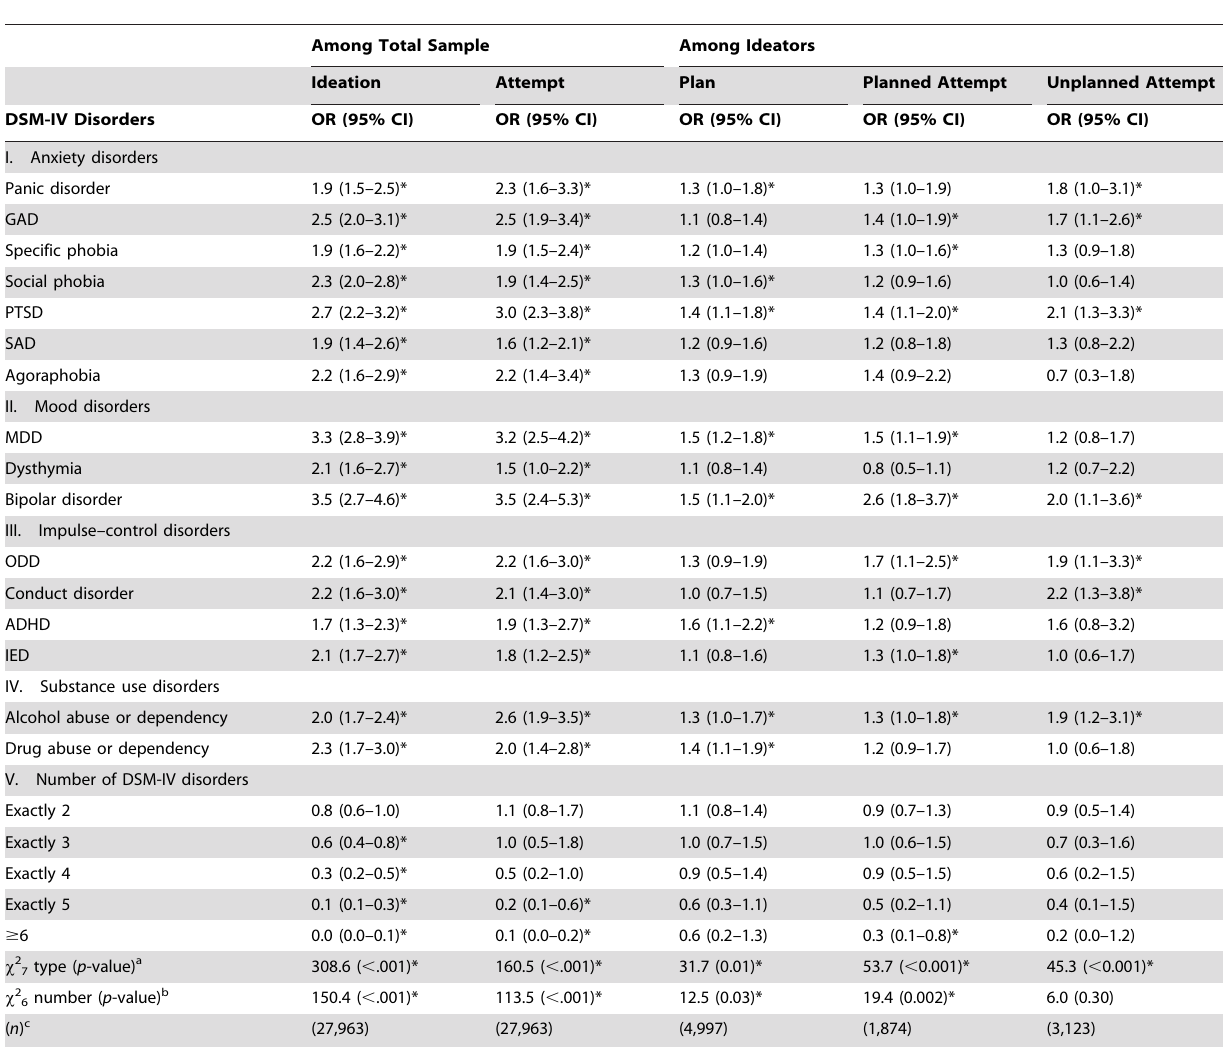
Table 6. Multivariate survival models of associations between type/number of prior DSM-IV disorders and subsequent suicidal behavior—developed